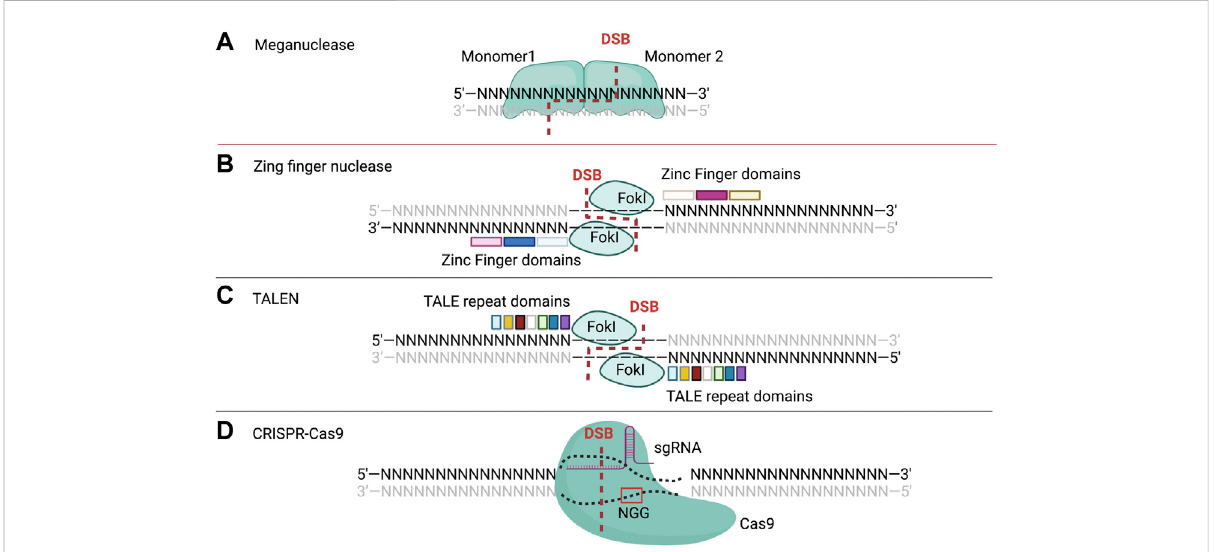
FIGURE 1 The (A) is depicting the two monomer domains (monomer 1 and monomer 2) of mega nuclease which cleave at the binding sites, resulting in the DNA double strand break. The (B) shows the two zinc fi nger domains of ZFNs made of three ZF motifs distinct binding sites (sequence of 3 nucleotides) and cleaving domains (FokI). The (C) represents TALE repeat domains (shown in colored squares) pair with distinct binding DNA nucleotides and cleaving domains (FokI). The (D) shows the single guide RNA complexed with Cas9 to open and cleave the DNA